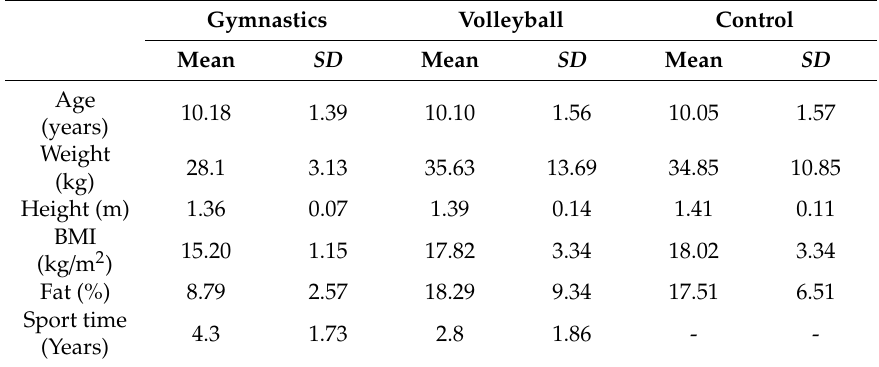
Table 1. Participants’ characteristics according to the group (gymnastics, volleyball and control